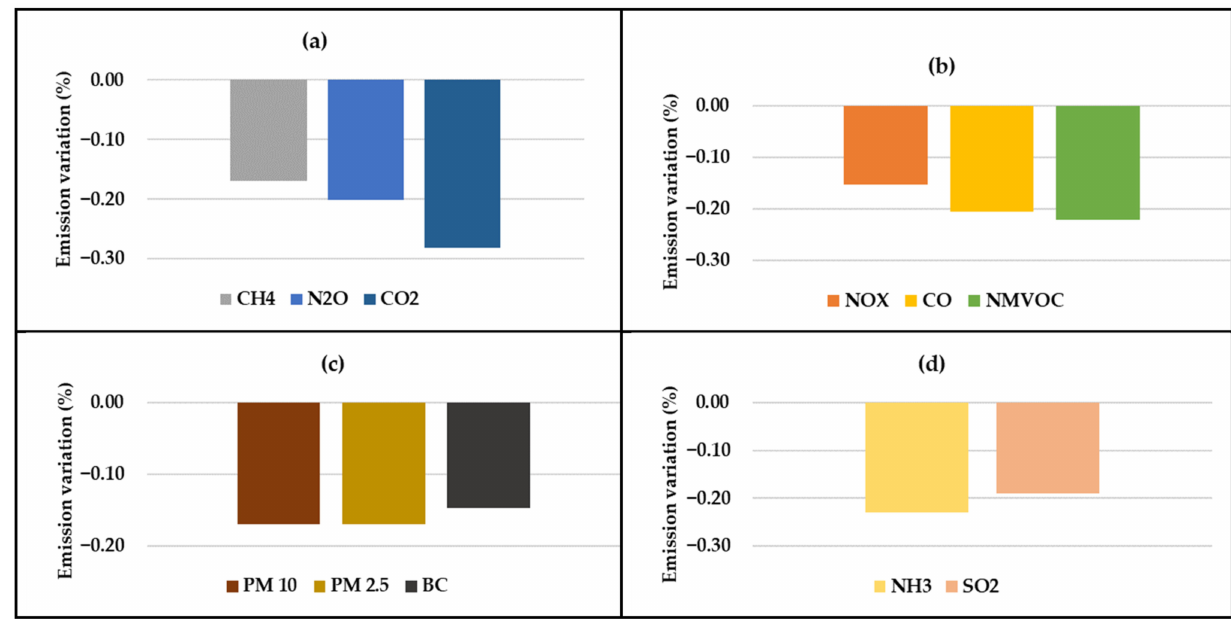
Figure 3. Emissions variations of the four groups of pollutants in the study: ( a ) GHGs; ( b ) ozone precursors; ( c ) aerosols; ( d ) acidifying gases, during the January to June 2020 in relation to the same period of